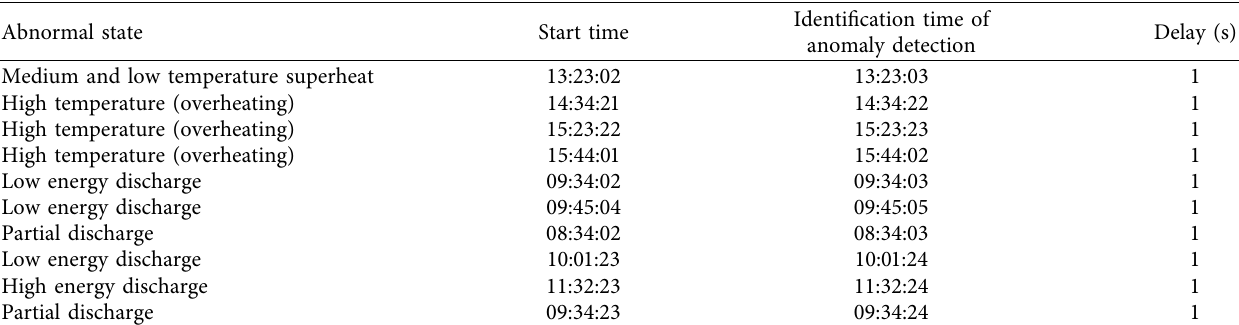
Figure 7: Identifcation error of multiple methods. Table 2: Real time test results of IEEE 14 node power system state estimation and anomaly detection